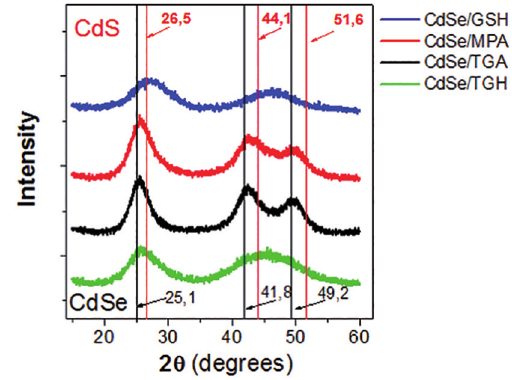
Figure 7: XRD patterns of CdSe QDs capped with MPA, GSH, TGA, and TGH. The graphic shows the diffraction peak positions for CdSe (bottom pattern) and CdS (upper